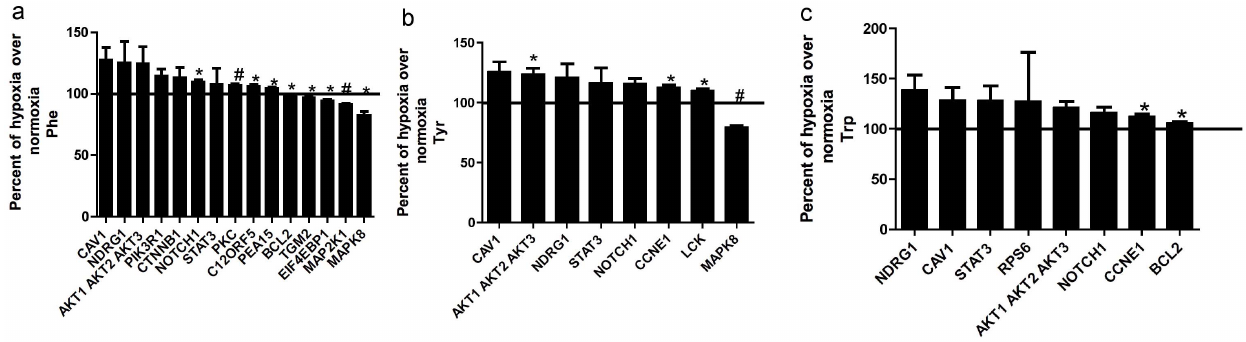
Figure 2. Aromatic amino acid stimulated effects on signaling pathways under normoxic vs hypoxic conditions. Reverse-phase protein array graphs of two sets of BMMSCs grown under normoxic conditions (21% O 2 /5% CO 2 ) and under low O 2 tension (3% O 2 /5% CO 2 ; physiologic hypoxia). When cells were 80% confluent they were treated with Phe, Tyr or Trp (100 m M) in serum-free media for 3 h. The cells were washed twice with PBS and lysis buffer was added to the plates. a-Phe, b-Tyr and c-Trp. Results are expressed as means 6 SEM for three independent experiments. * p # 0.05 and # p # 0.01. Percent change of hypoxia over control for Phe was determined as percent change of BMMSCs treated with Phe under hypoxic conditions (3% O 2 %) vs. BMMSCs treated with Phe under normoxic conditions (21% O 2 ) (control=100%). Both sets of BMMSCs were treated with Phe and grown under different oxygen levels. Same for Tyr and Trp pannels. RPS6: Ribosomal protein s6 (S6_pS240_S244-R-V). CAV1: Caveolin 1 (Caveolin-1-R-V). NDRG1: N-myc downregulated gene (NDRG1_pT346-R-V). AKT1 AKT2 AKT3: protein kinase B (Akt_pT308-R-V). STAT3: Signal transducer and activator of transcription 3 (STAT3_pY705-R-V). CTNNB1: b -catenin (beta-Catenin-R-V). NOTCH1: Notch homolog 1 (Notch1-R-V). MAP2K1: Mitogen activated protein kinase (MEK1-R-V). EIF4EBP1: Eukaryotic initiating factor 4 (4E-BP1_pT37_T46-R-V). MAPK8: c-Jun